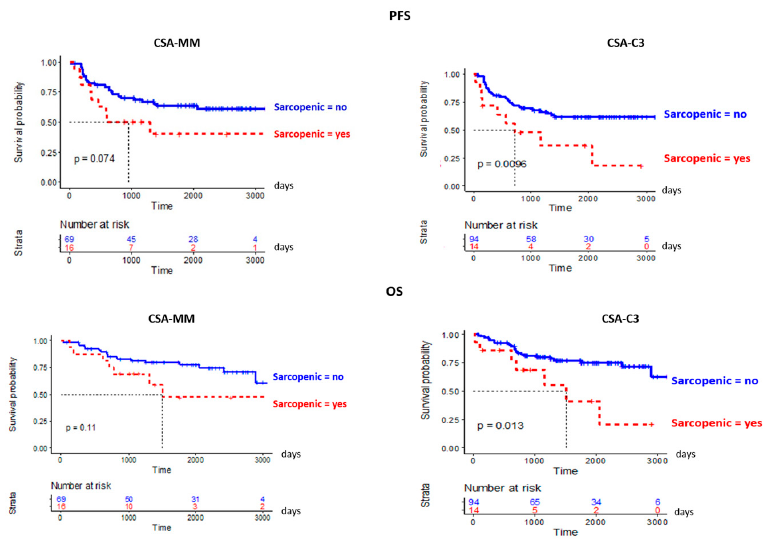
Figure 3. KM curves for OS and PFS of patients become sarcopenic during RT vs. never sarcopenic, based on MM-CSA and C3-CSA.